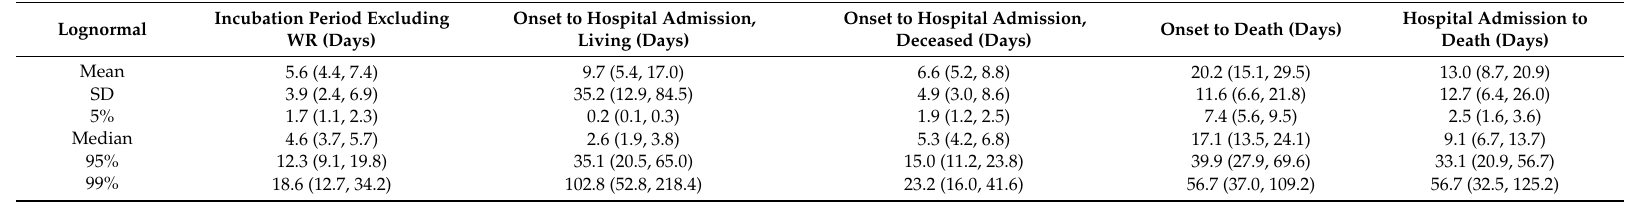
Right-truncated incubation period and other time-delay distributions for COVID-19 outbreak cases reported in January 2020 applied to the lognormal